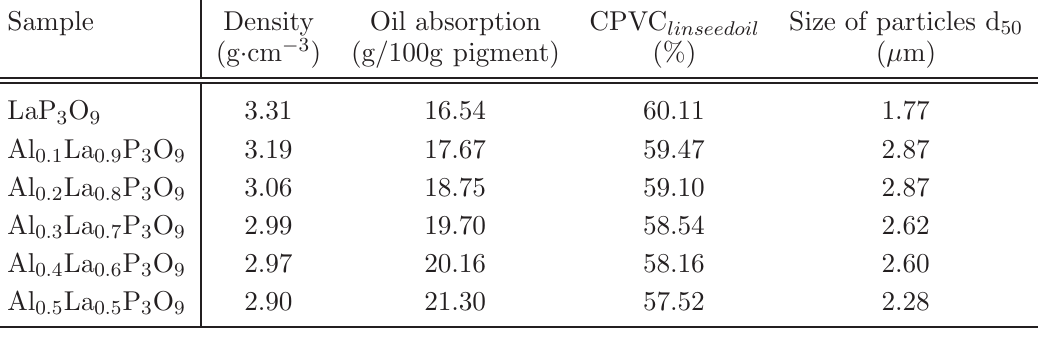
Table 1 Characteristics of prepared triphosphates.